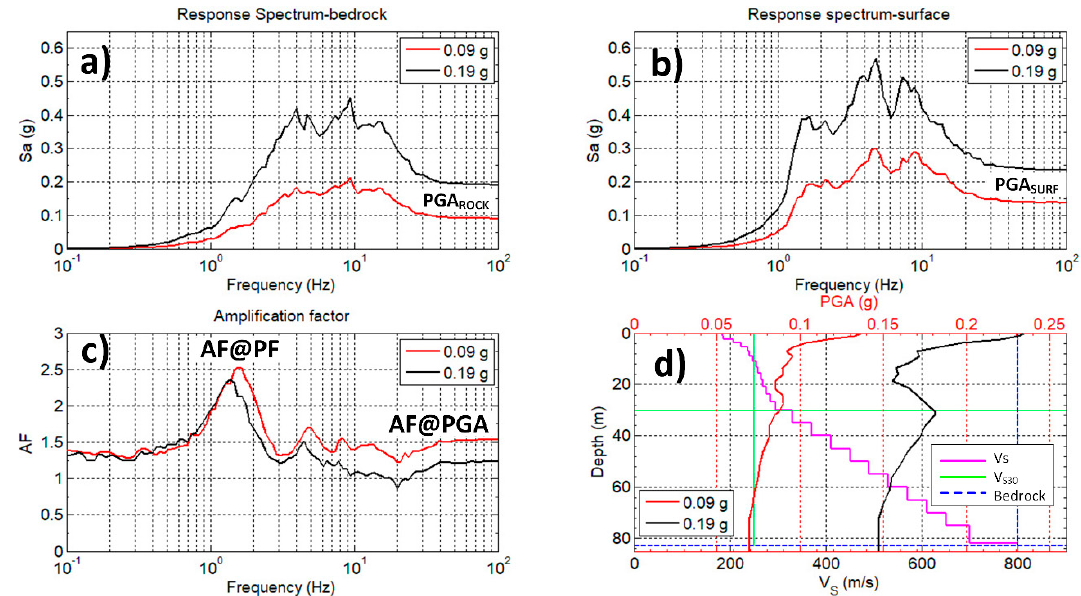
Figure 12. Example of the 1-D EQL site response analysis result for location 42. ( a ) Input median response spectrum at the bedrock from the suite of previously recorded rock acceleration time series for PGA ROCK = 0.09 g (95yrp) and 0.19 g (475yrp). ( b ) Median response spectrum at the surface. ( c ) Amplification factor AF is calculated as the ratio of the surface response spectrum to the rock (bedrock) response spectrum at 5% of critical damping. AF@PGA marks AF at the top of the soil model (ground surface) and AF@PF marks amplification factor at predominant spectral peak frequency. ( d ) Variation of the input ground motion PGA ROCK from the bedrock depth through shear wave velocity Vs model to the surface represented by peak ground acceleration - PGA .